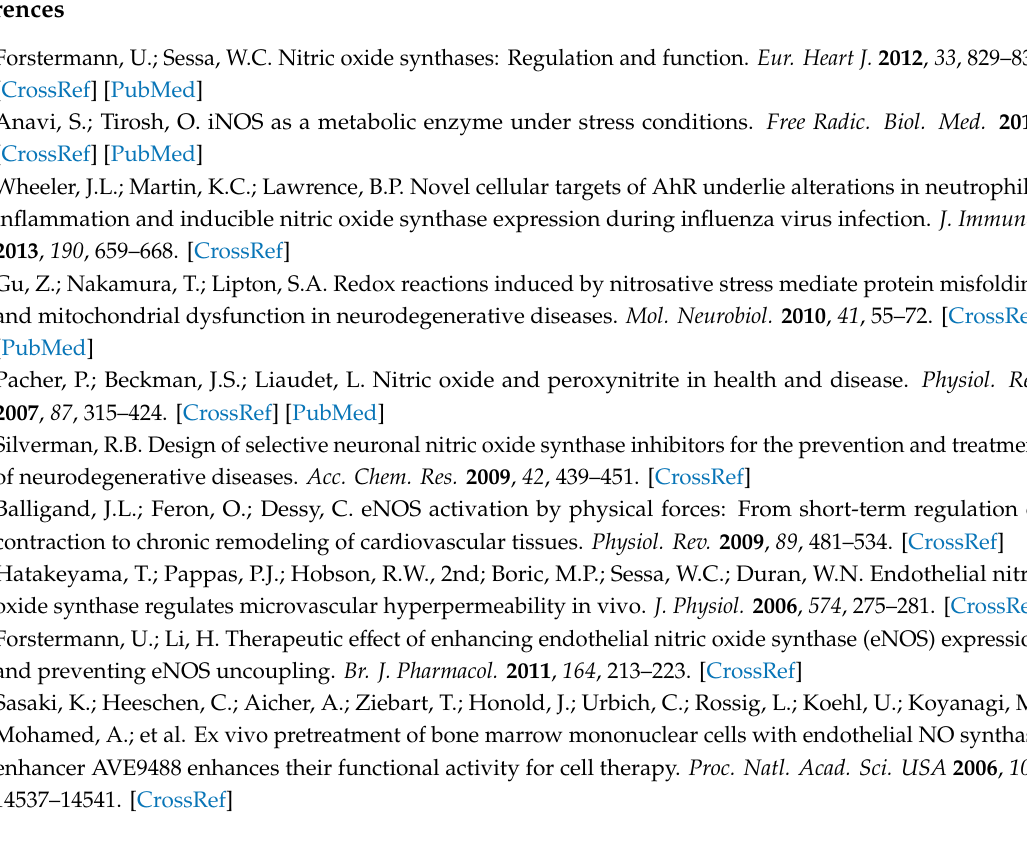
Figure A7. Fluctuations of the distance between the NH2 termini of NT1, NT3_3, NT3_5, and NT3_7 and FAD; the two main levels are highlighted by blue bars during one representative run of 20 ns out of three.